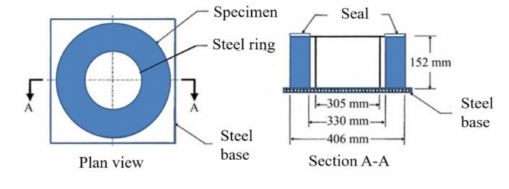
Figure 3. HPC restrained shrinkage ring test